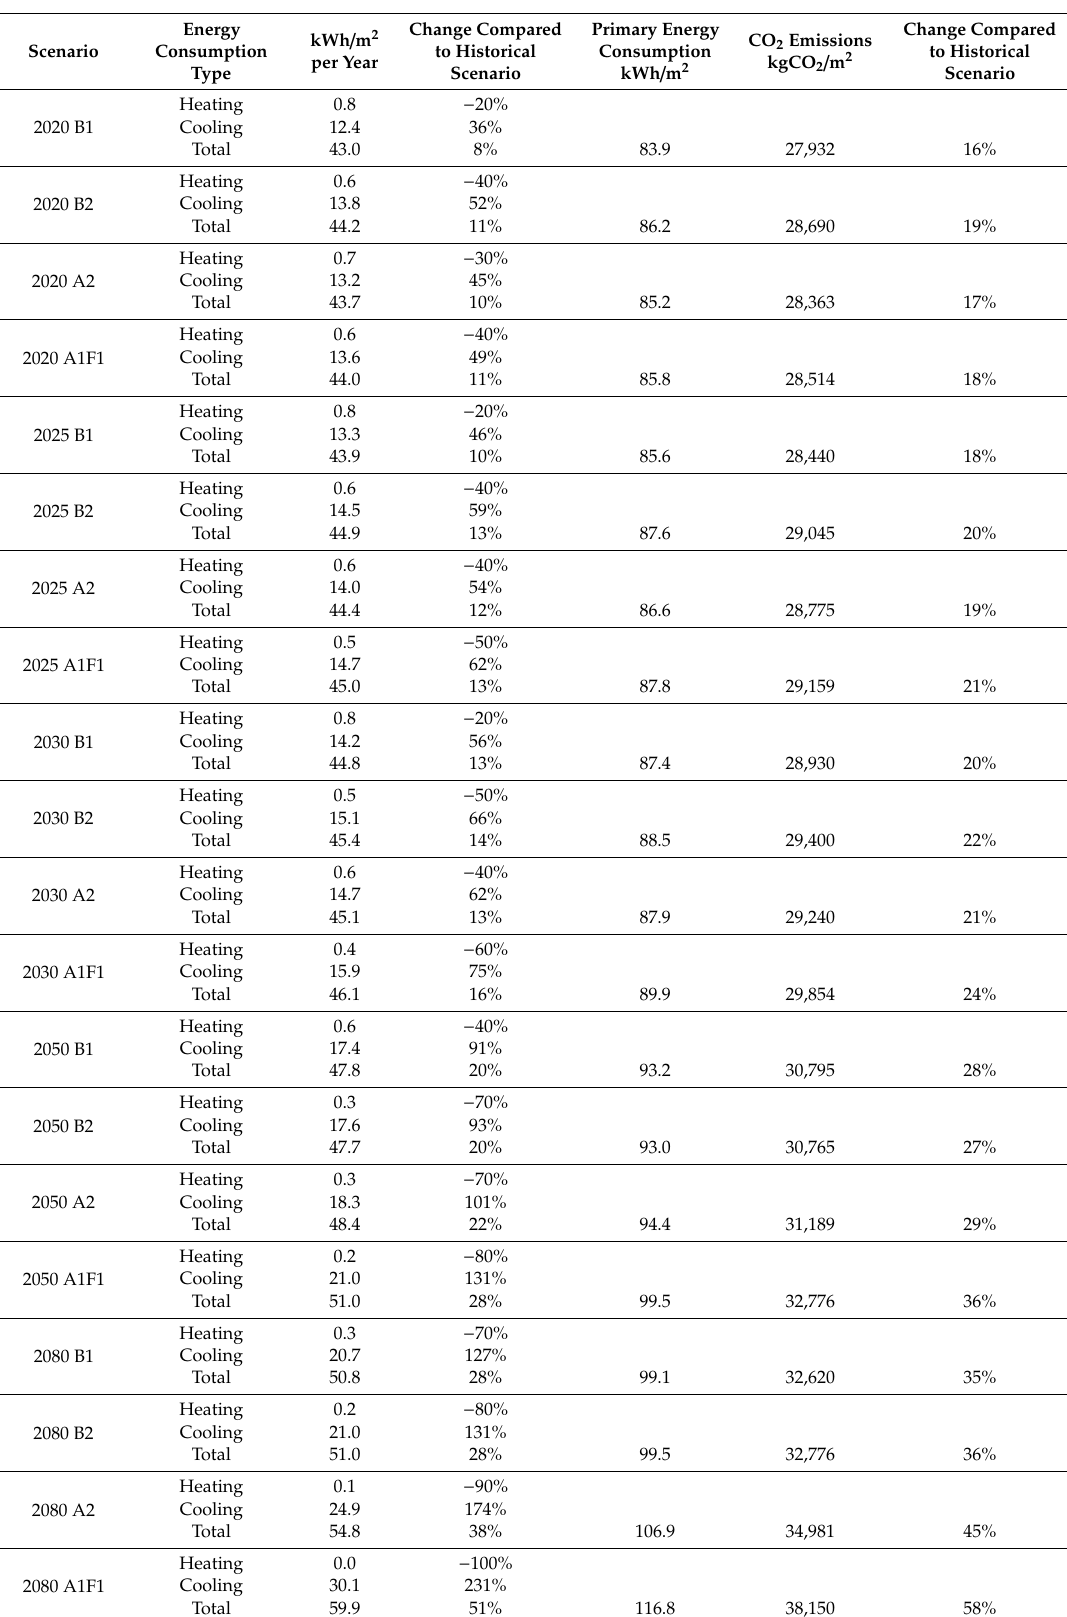
Table A2. Summary of energy consumption and CO 2 emissions in present and future scenarios and